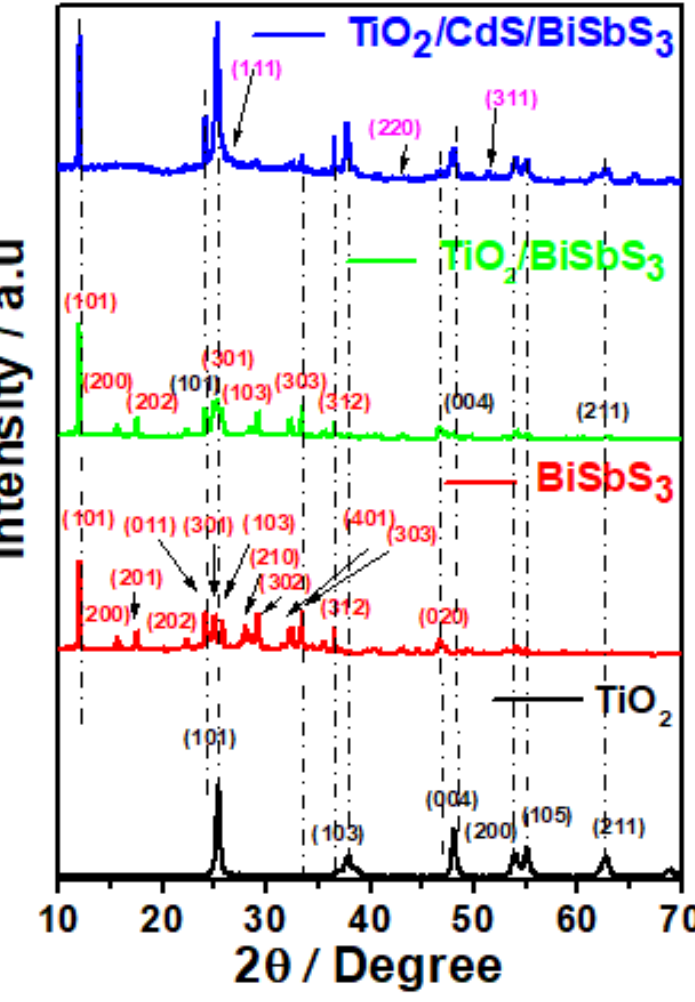
Figure 2. XRD patterns of fabricated electrodes (Black color is related to TiO 2 , Red color corresponds to BiSbS 3 , whereas Magenta color is related to CdS).